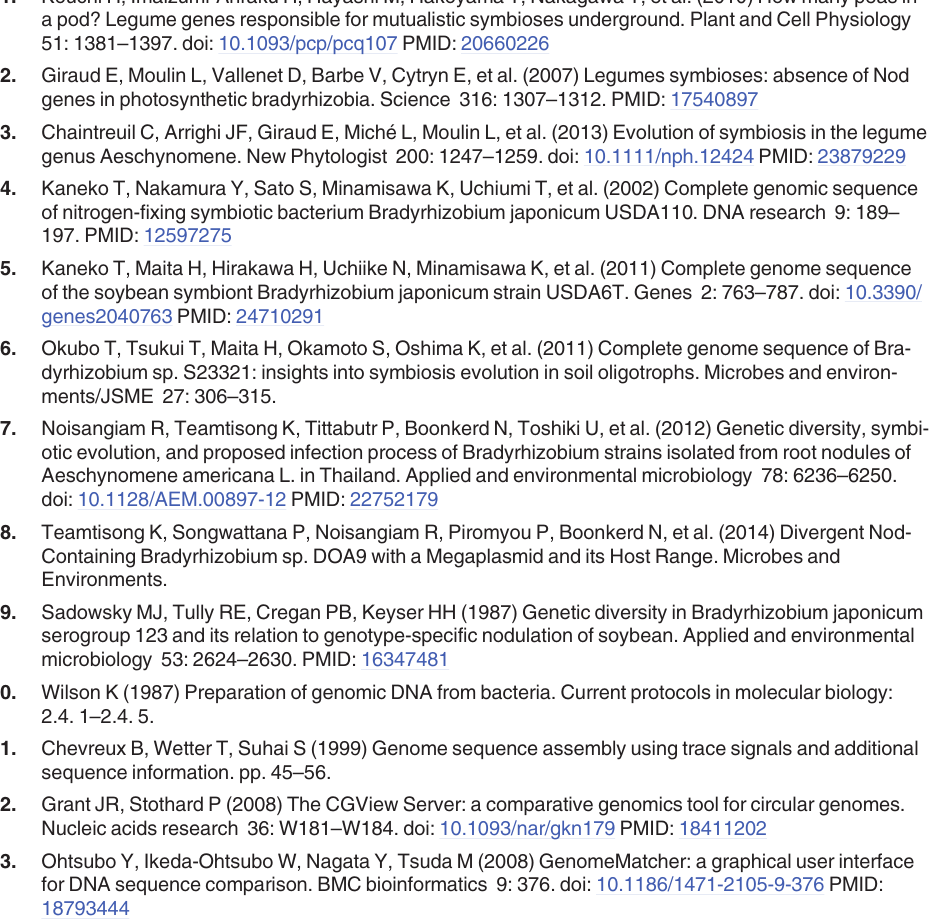
S1 Table. Nitrogen fixation genes detected in the genome of Bradyrhizobium sp. DOA9 and higher BLASTP similarity with other microorganisms. S2 Table. Genes encoding the type III secretion system in the genome of Bradyrhizobium sp. DOA9 and higher BLASTP similarity with other microorganisms. S3 Table. Genes encoding the type IV secretion system in the genome of Bradyrhizobium sp. DOA9 and highter BLASTP similarity with other